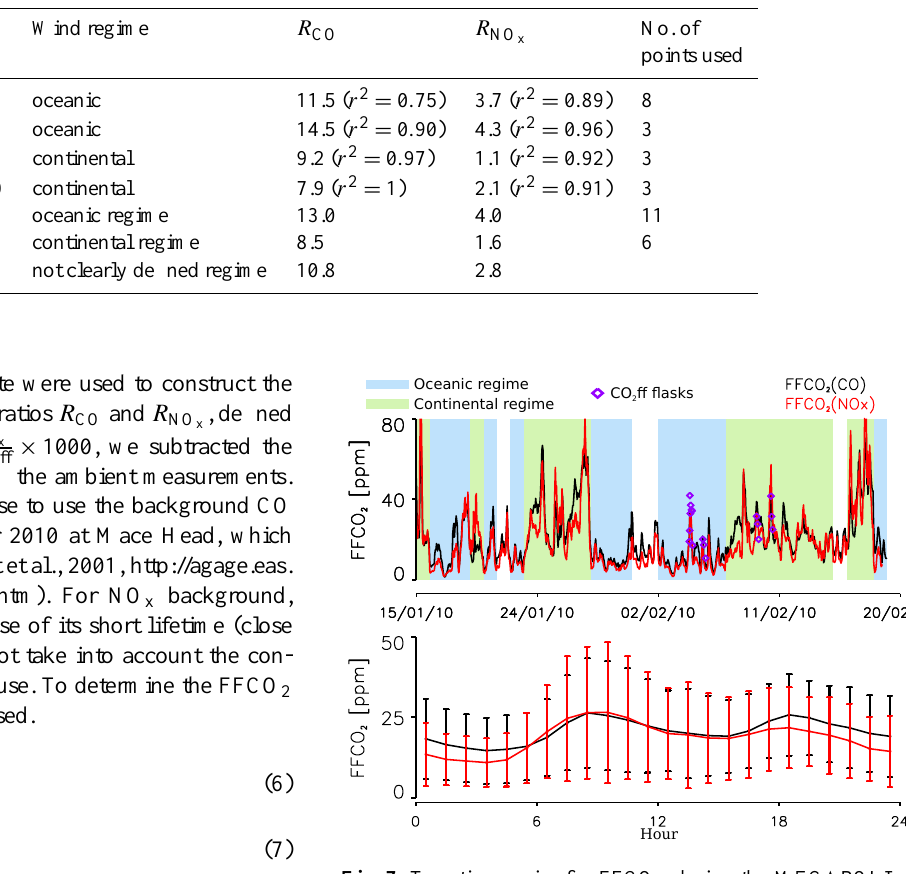
Table 4. CO ( R CO ) and NO x ( R NO ) ratios with their respective coefficients of determination ( r 2 ) and the number of points used for CO 2 ff CO 2 ff x each sampled day and the corresponding values used for each regime (3 last lines).